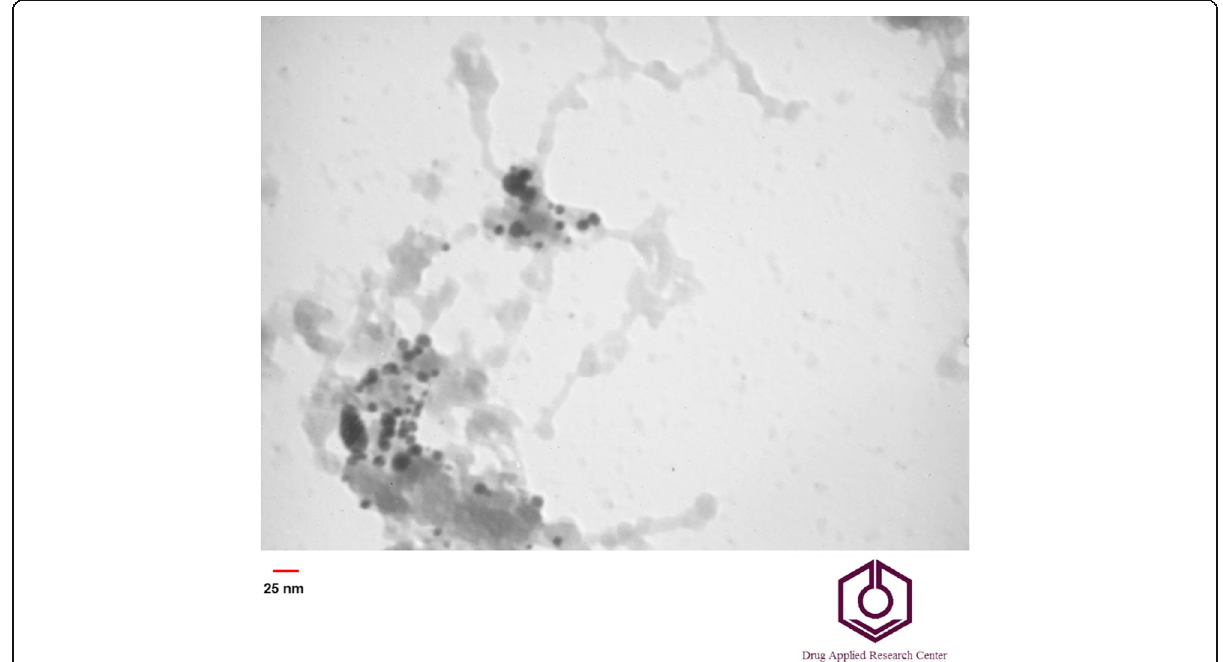
Fig. 3 TEM image of Au@SiO 2